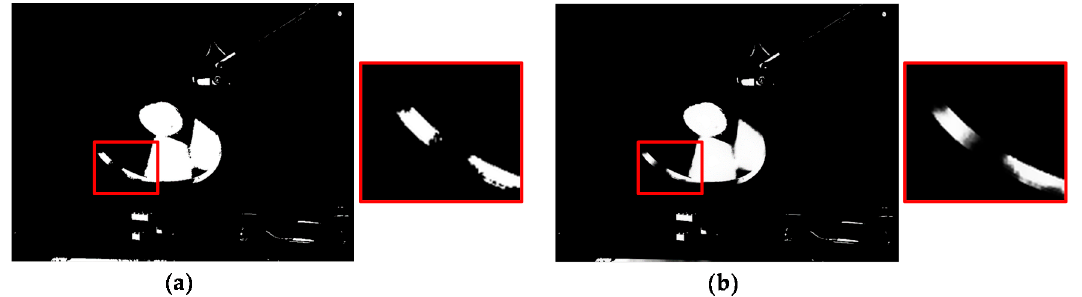
Figure 12. Restoration radiance values for holes. Figure 13. ( a ) Under/over-exposed region map, S ; and ( b ) weight map, W .